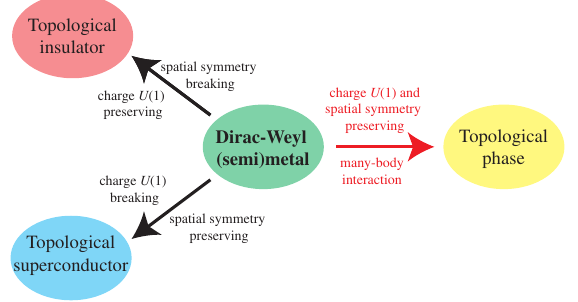
FIG. 1. Symmetry-breaking single-body gapping versus sym- metry preserving many-body gapping of a Dirac-Weyl